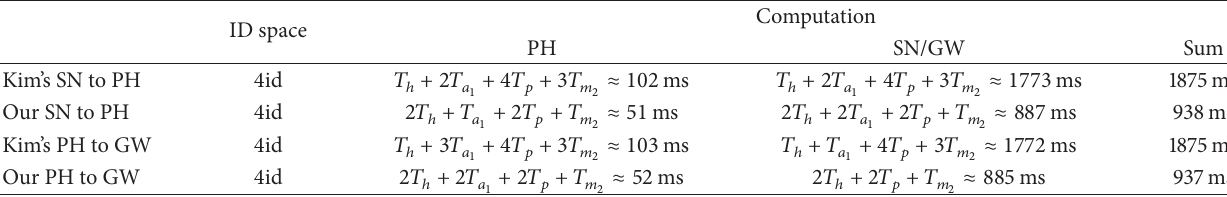
Table 6: Computation performance comparison with Kim’s scheme